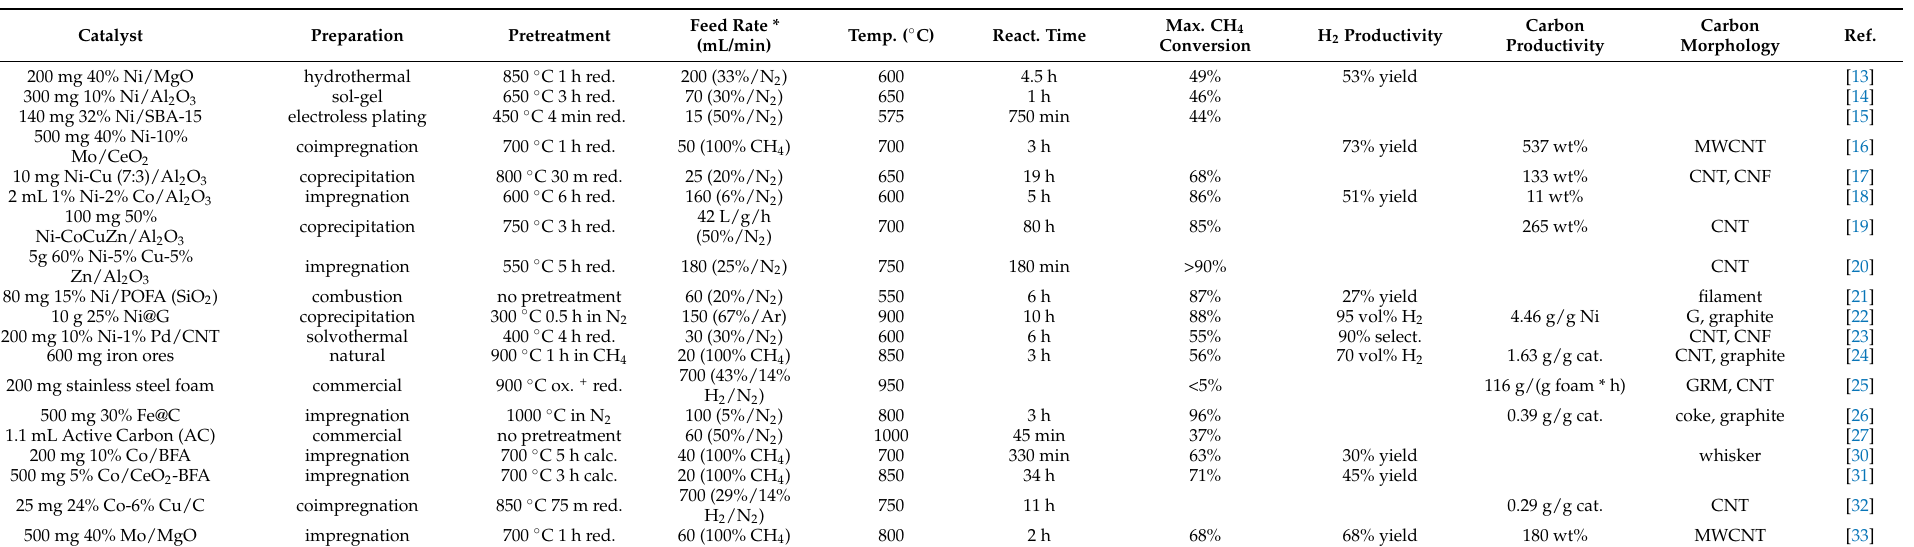
Table 1. Results on best-performing solid catalysts in methane pyrolysis in 2021–2022